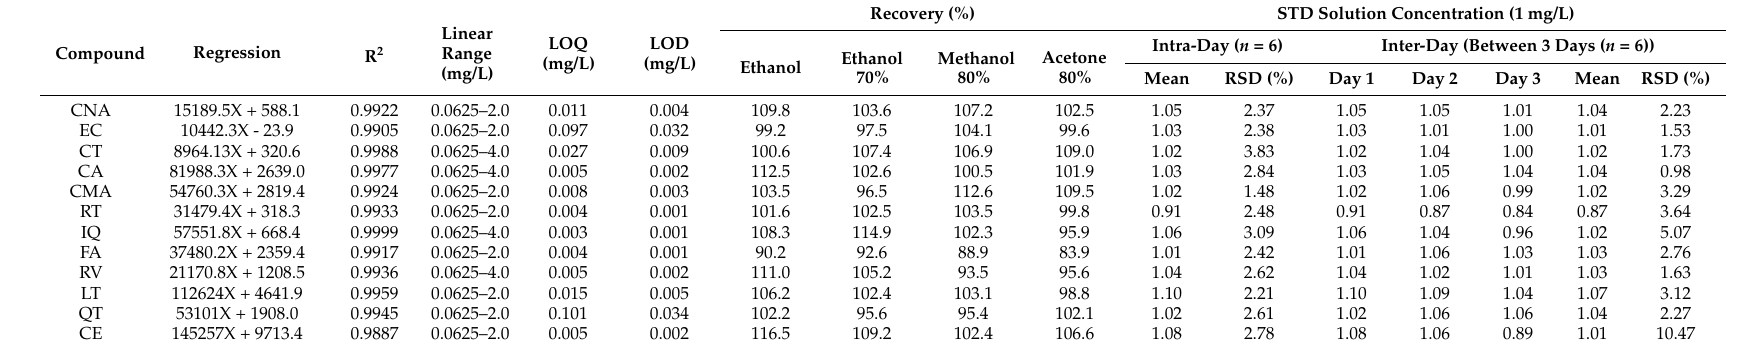
Table 2. Regression, linear range, LOD, LOQ, recoveries, and precision of the 12 phenolic